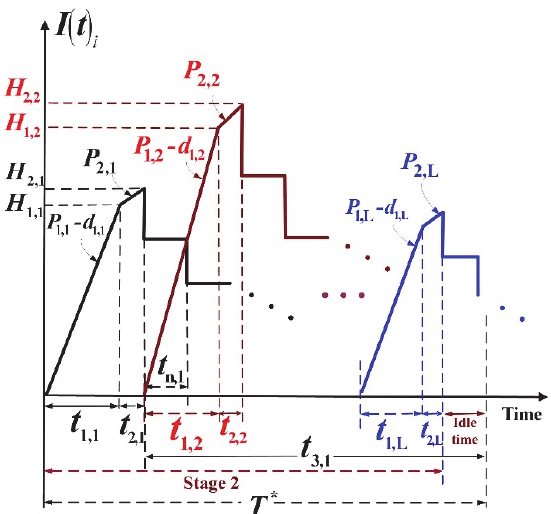
Fig. 2 . On-hand inventory level of perfect quality L customized end products in stage two of the proposed two- machine two-stage fabrication scheme